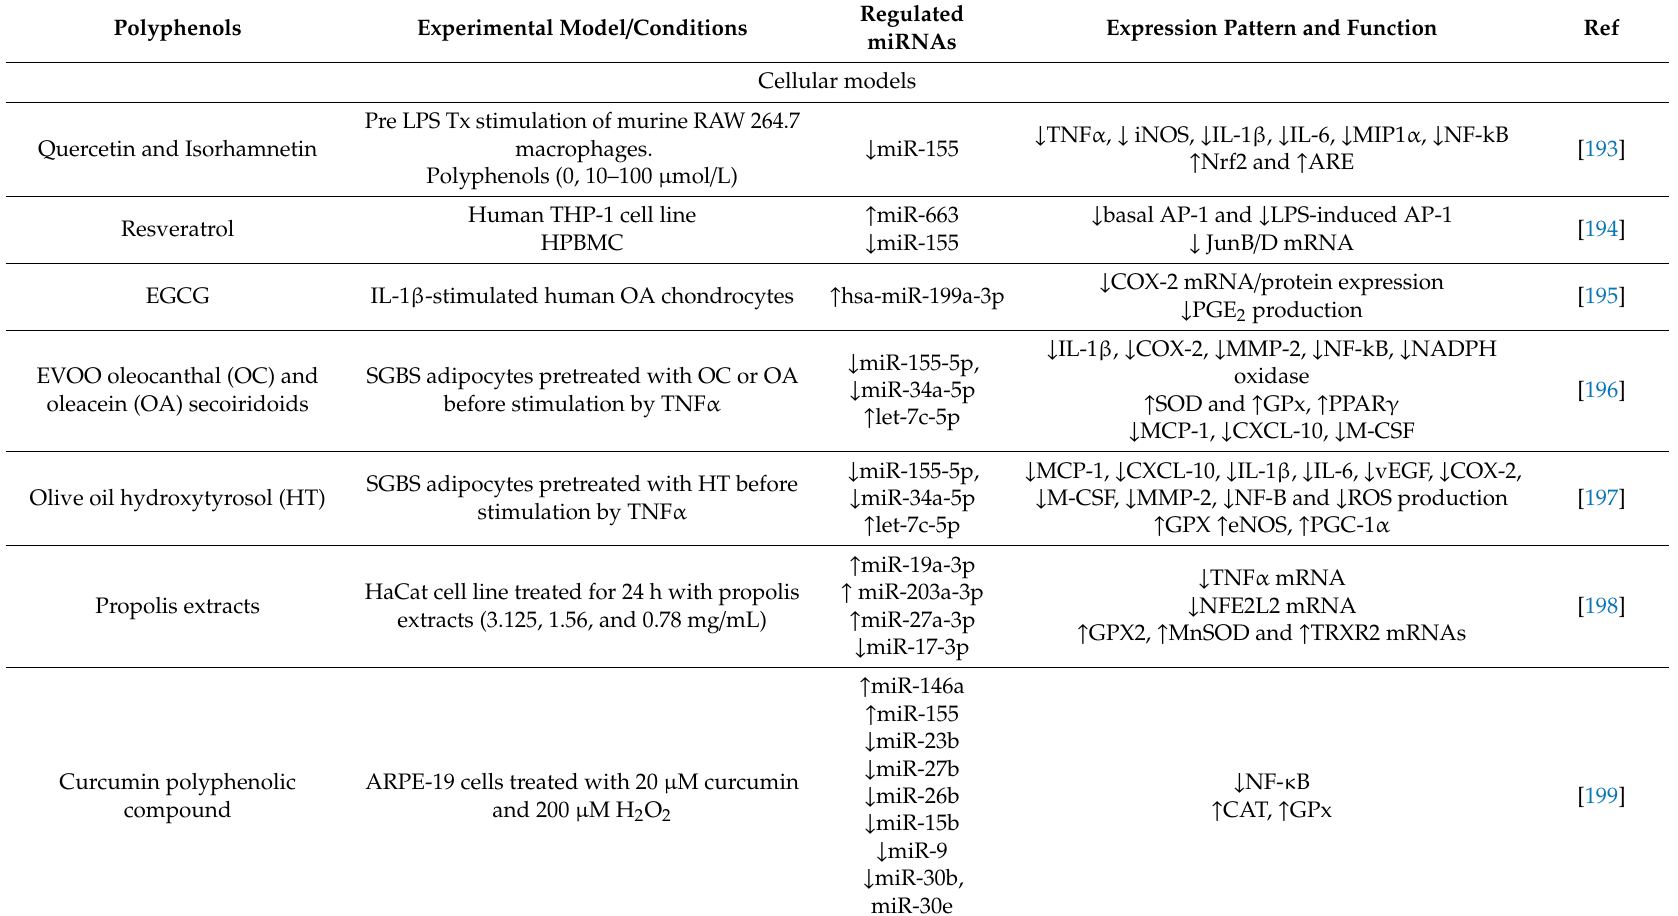
Table 4. E ff ects of polyphenols on the regulation of miRNAs on oxidative and inflammation